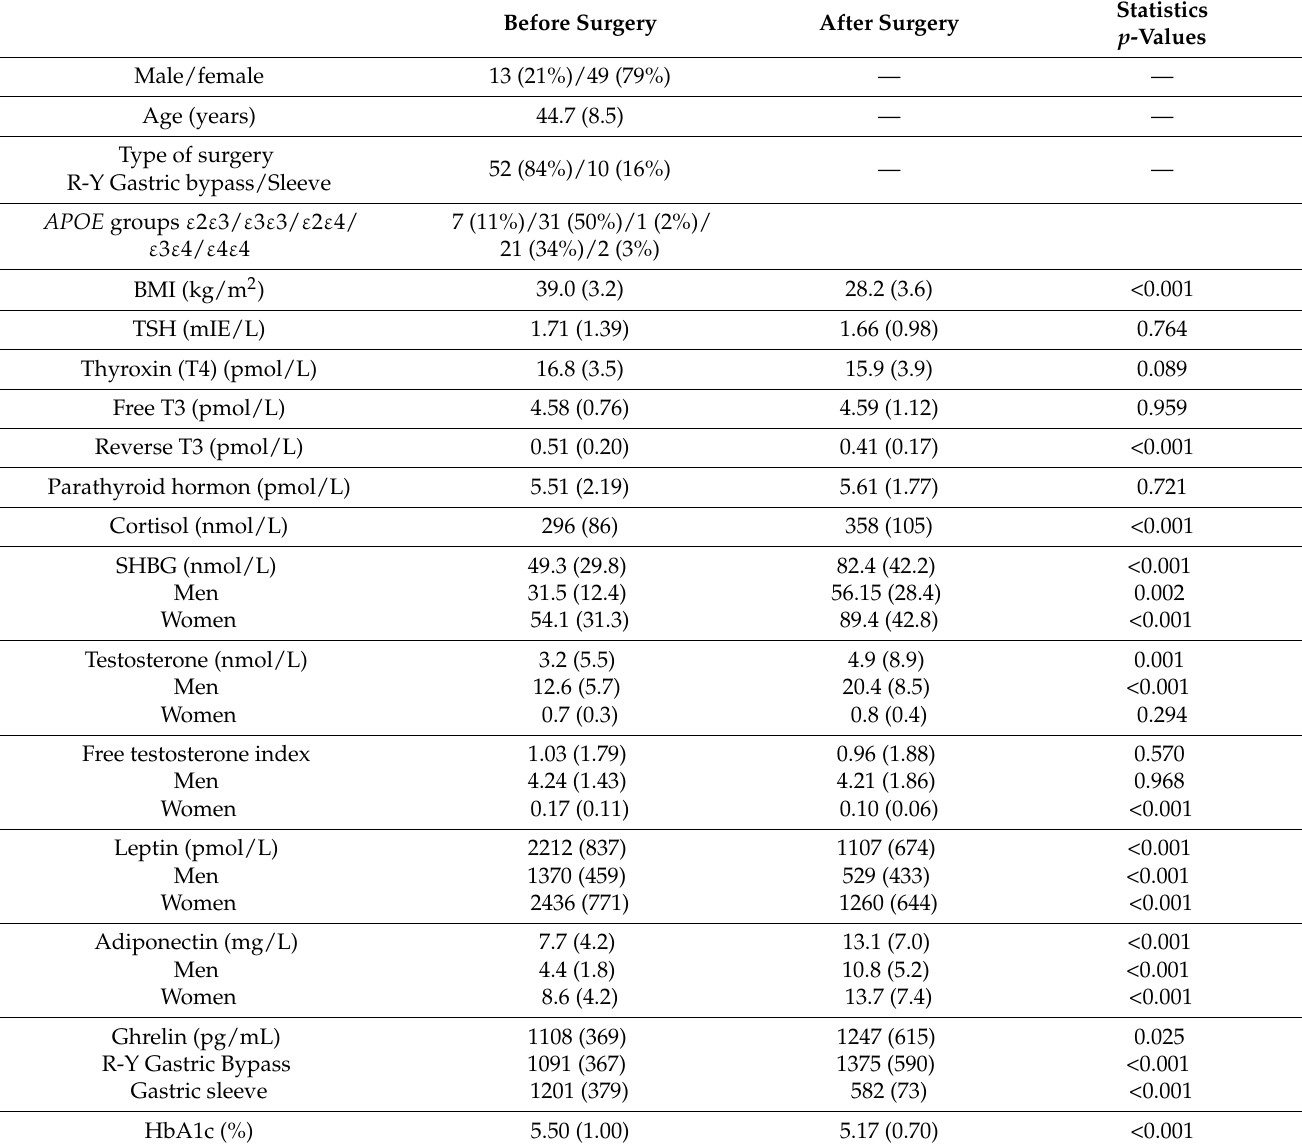
Table 1. Patient characteristics. For gender-dependent variables, values are given for men and women. Before Surgery After Surgery